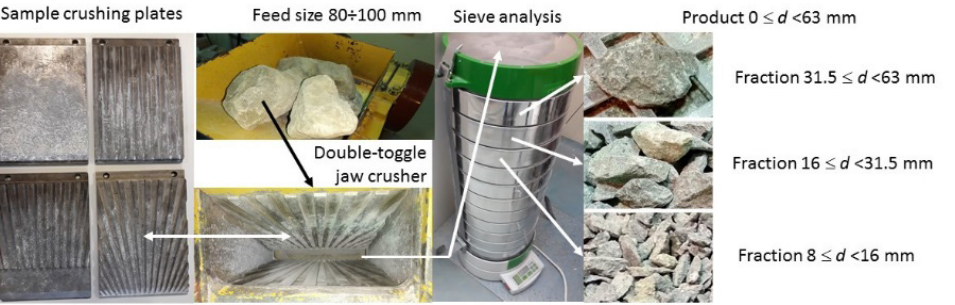
Figure 11: Diagram of crushing process – feed size, crusher’s working chamber, sample crushing plates, sample product fractions (fraction 8-16, 16-31.5, 31.5-63 mm)